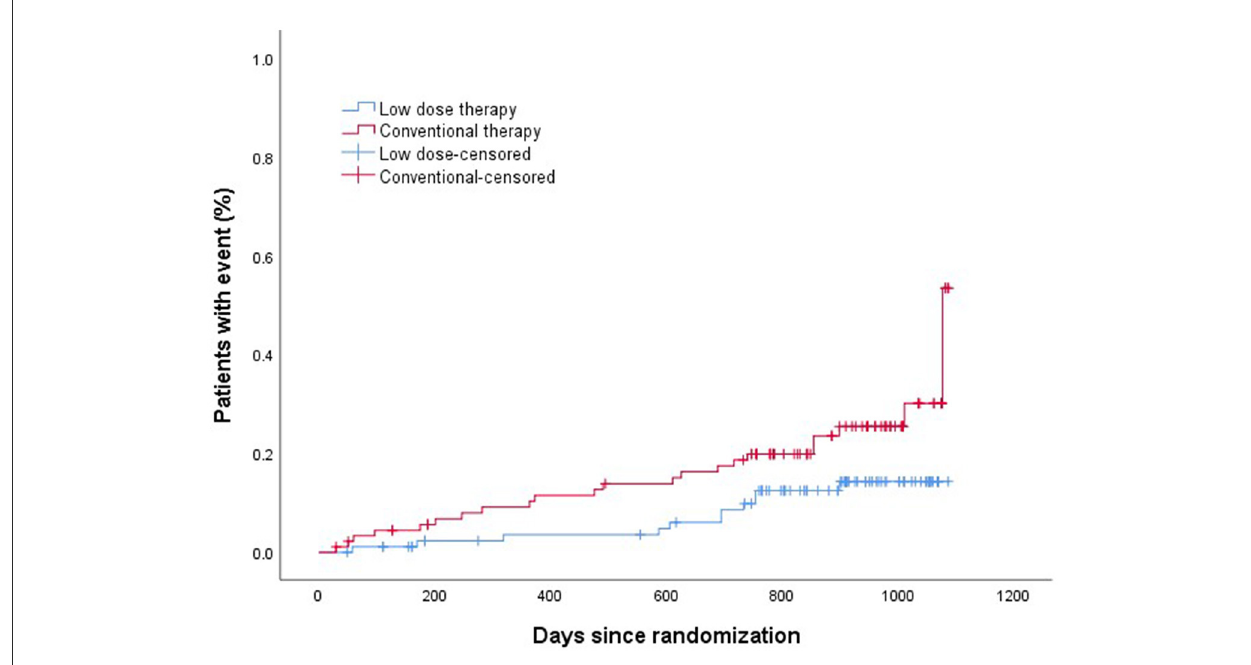
FIGURE2 Kalpan–Meier analysis of composite safety outcomes.